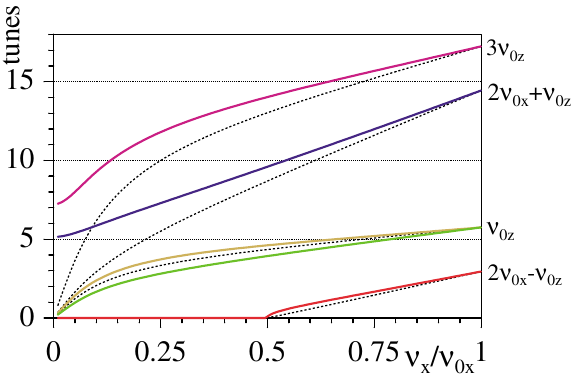
FIG. 4. (Color) Analytic instability growth rates (normalized) (cid:3) (cid:3) 0 : 8 and (cid:19) (cid:3) 2 as a function of the =(cid:10) =(cid:19) for constant (cid:10) x z x 0 z 0 x betatron tune ratio and including all modes up to fourth